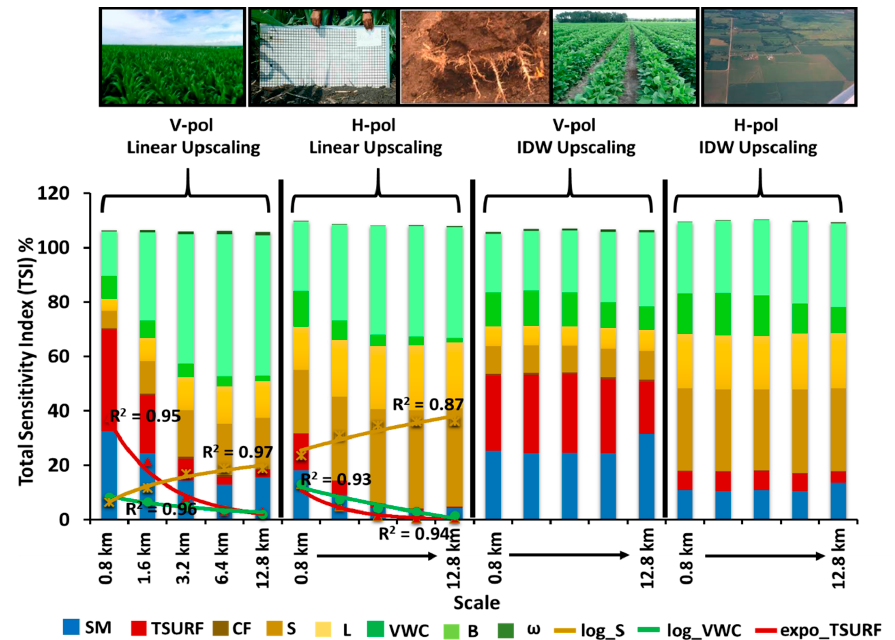
Figure 5. Soil Moisture Experiments 2002 (SMEX02), Total Sensitivity Index (TSI) for Brightness Temperature under V-polarization, and H-polarization using Inverse Distance Weighted (IDW) and Linear Upscaling. SM: Soil Moisture; CF: Clay Fraction; S: Root Mean Square Height; L: Correlation Length; TSURF: Surface Temperature; VWC: Vegetation Water Content; B: Vegetation Structure; ω : Single Scattering Albedo. The brown and green curves represent a logarithmic fit to S (log_S, V-pol: R 2 = 0.97 & H-pol: 0.87) and to VWC (log_VWC, V-pol: R 2 = 0.96 & H-pol: 0.93), while the red curve represents an exponential fit to TSURF (expo_TSURF, V-pol: R 2 = 0.95 & H-pol: 0.94). The symbols represent the TSI values of the respective variables, while R 2 represents the goodness of fit.